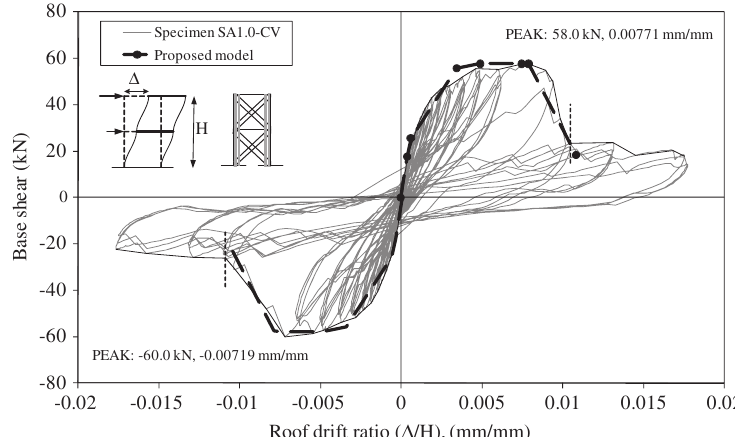
Figure 11 Response of specimen SA1.0-CV.